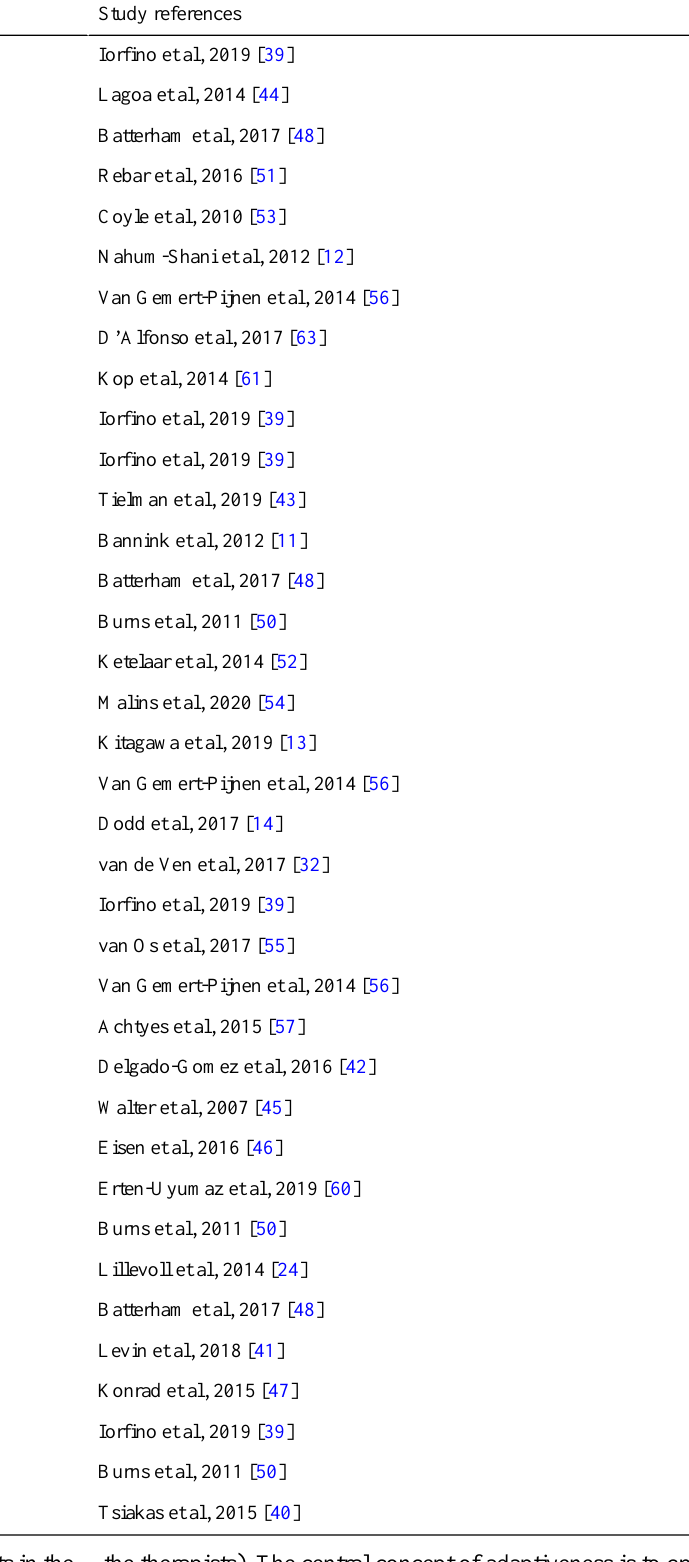
Table 3. Types of adaptive elements identified from the relevant